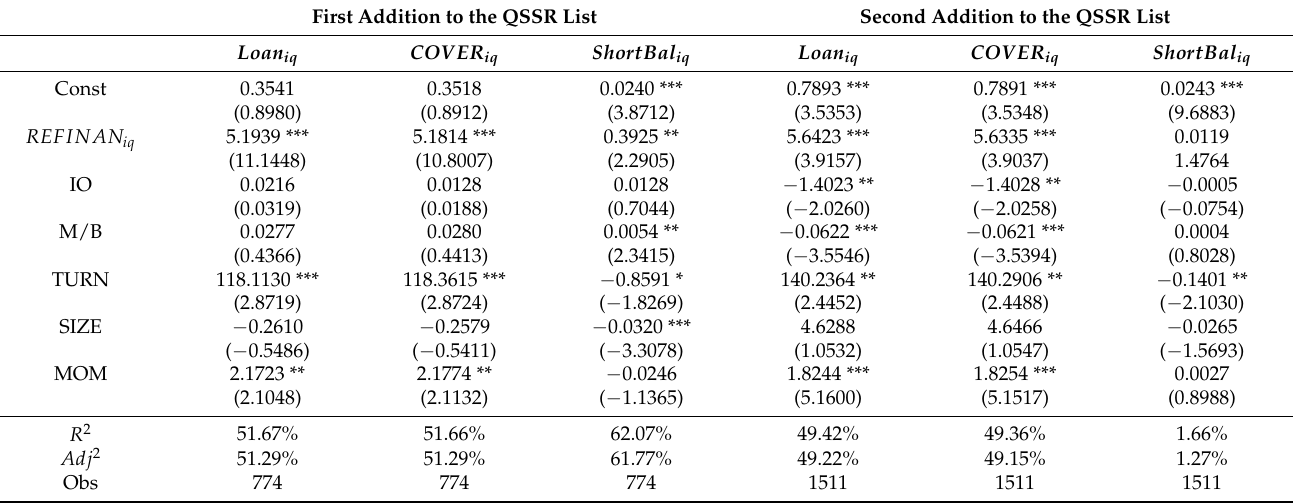
Table 6. Panel data regressions of short-sale volume on short-sale refinancing